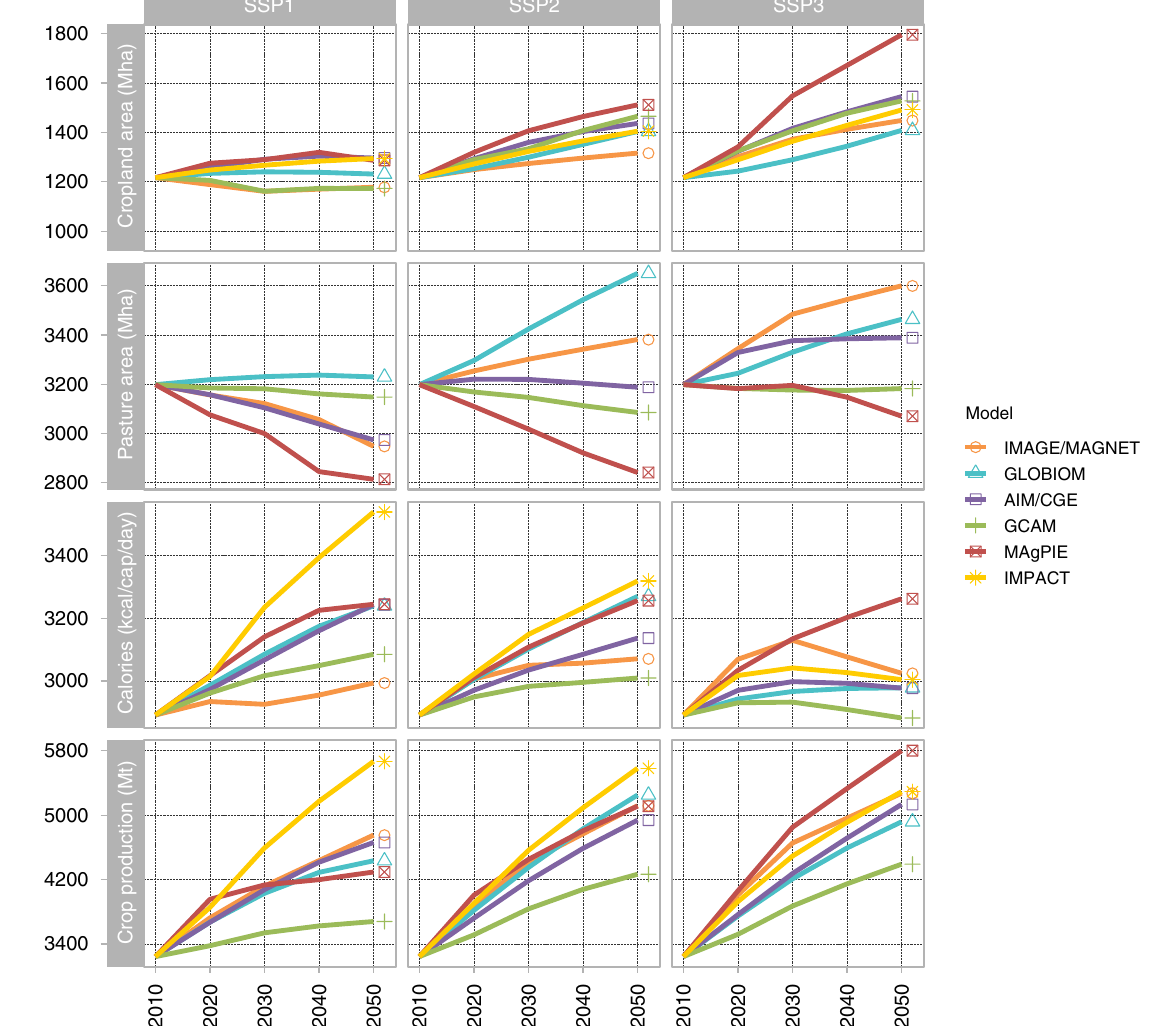
Fig. 1 Key characteristics of global agriculture and land use in SSP1, SSP2 and SSP3. Model results were standardized to a common value in 2010. The order of models in the legend follows the publication of land use in the SSPs, with SSP1, SSP2, SSP3, SSP4 and SSP5 being represented by IMAGE, GLOBIOM, AIM, GCAM and MAgPIE, respectively